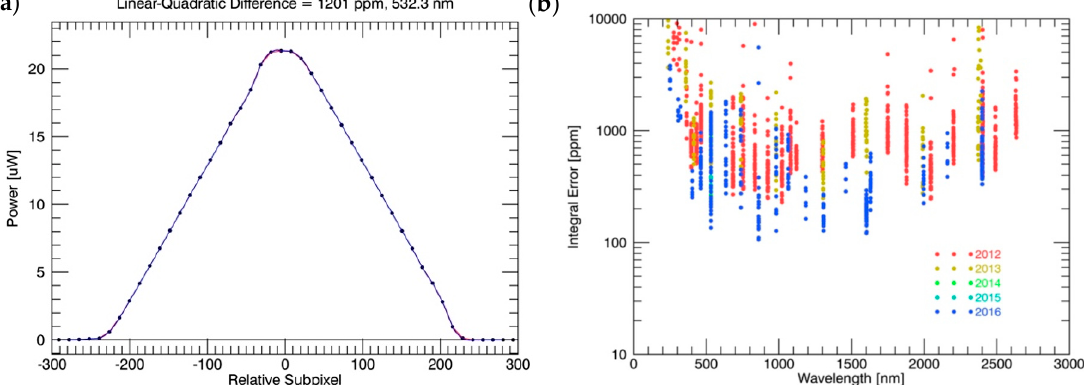
Figure 14. ( a ) Measured spectral instrument profile for 532 nm prism scan plotted as a function of linear focal plane positional coordinates (sub-pixels, c) that defines prism angle relative to the central wavelength angle. Prism angle sampling size reflects operational step size used for SSI measurements. Shown are two separate interpolation methods (linear and quadradic) used to provide numerical power integration of the full profile shown in Figure 13. ( b ) The relative integral error based on these two separate interpolation methods. The results are shown for the full set of spectral instrument profiles covering 236 nm through 2700 nm over five years of separate calibration campaigns. The final 2016 pre-launch calibration is used for the uncertainty budget and show relative integral uncertainties less than 1000 ppm (0.1%) for the majority of the spectrum (with shortest UV wavelengths showing integrated uncertainties in the 0.1–0.3% range).